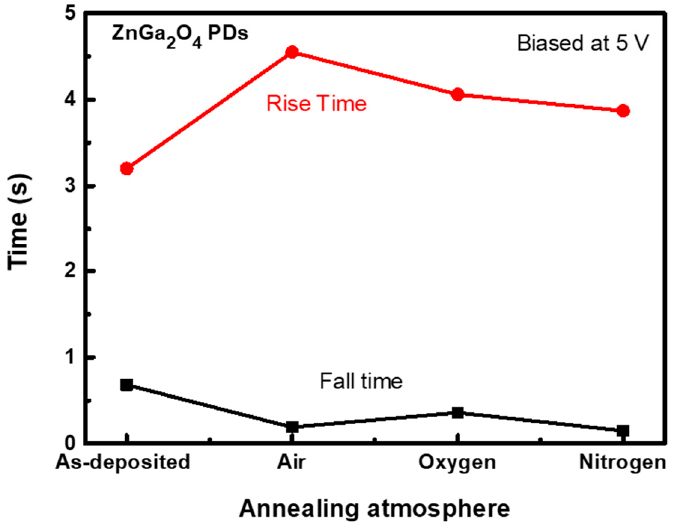
Figure 8. Time response of as-deposited and annealed ZnGa 2 O 4 PDs under different annealing am- biences.